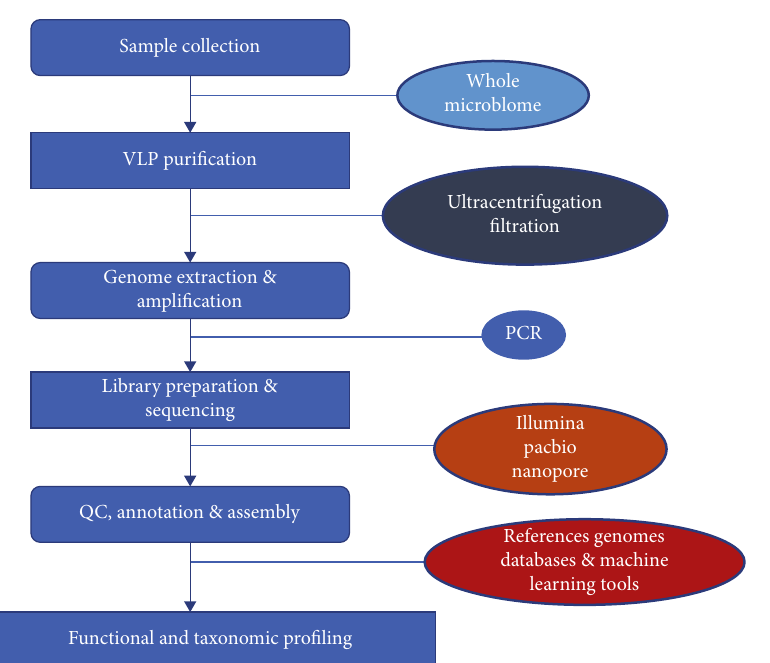
Figure 1: Viral metagenomic work fl ow. A schematic representation of the steps and processes involved in the isolation, identi fi cation, and analysis of the virome. Following sample collection, the sample is puri fi ed through a series of steps involving ultracentrifugation and fi ltration to retain the virus-like particles (VLPs). This is followed by extraction steps to isolate the genomes of the VLPs which are then ampli fi ed by PCR, utilized for library preparation and sequenced using sequencing technologies such as Illumina, Pacbio, or Oxford nanopore technology. The sequencing generates reads — short, long, or ultra-long — which are quality controlled, annotated, and assembled using di ff erent databases and machine learning tools. Finally, the identi fi ed VLPs are then subjected to taxonomic and functional pro fi ling to answer key biological